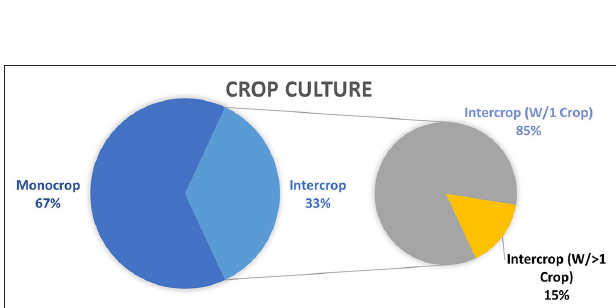
FIGURE 3 | Composition of 10,213 fields surveyed in Busia, Kenya between August 13th and December 12th,